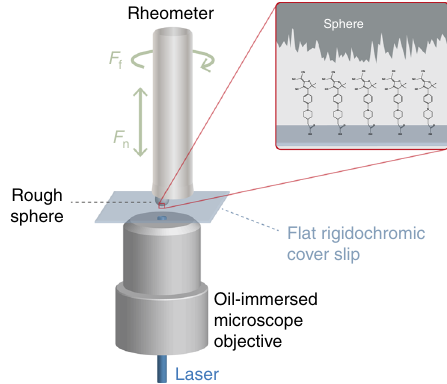
Fig. 1 Experimental setup. A rheometer is mounted on top of an inverted confocal laser scanning microscope (not to scale). We excentrically glue a rough sphere to the rheometer plate and make contact with a smooth and fl at, fl oat glass, coverslip. The rheometer measures normal and frictional forces on the contact. The inverted microscope excites a monolayer of rigidochromic molecules on the glass surface with 488 nm laser light and point scans images (at a large magni fi cation: ×63, numerical aperture 1.4) the resulting fl uorescence that is emitted at the real contact area between the sphere and the glass. Two beam splitters and a long pass fi lter are used to collect the fl uorescent light in a photomultiplier tube. To avoid strong light scattering and optimize image quality, we immerse the contacts in formamide and use transparent materials for the sphere: polystyrene (PS), poly(methyl methacrylate) (PMMA), polytetra fl uoroethylene (PTFE), and borosilicate